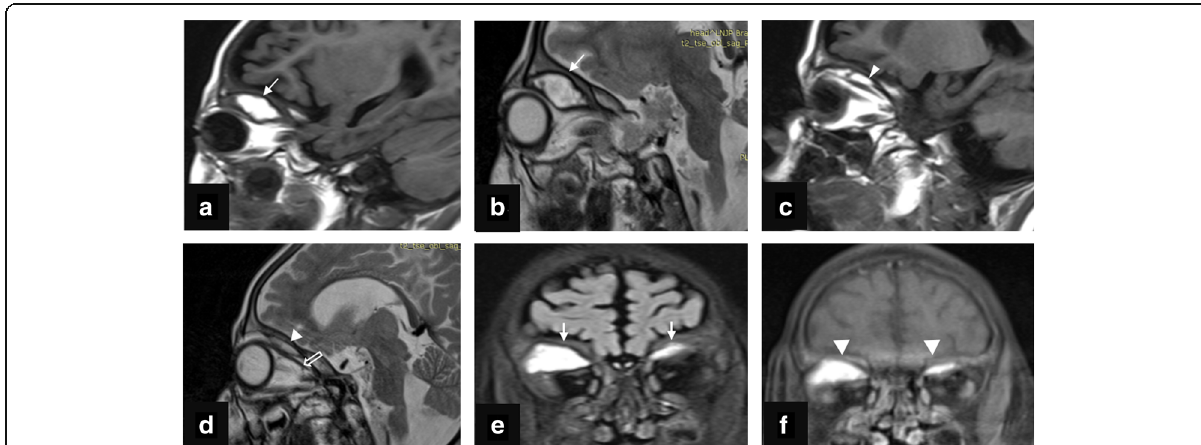
Fig. 3 a , b T1 and T2w sagittal images of right orbit reveal sharply marginated T1 and T2W hyperintense collection (arrows) along orbital roof with resultant downward displacement of superior rectus muscle. c , d T1- and T2-weighted sagittal images of the left eye reveal a similar smaller collection appearing hyperintense on T1 and T2W images (white arrowheads) along orbital roof with resultant downward displacement of superior rectus muscle (open arrow). e , f FLAIR coronal and T1 fat-suppressed images reveal the collections along bilateral orbital roof appearing hyperintense on FLAIR (arrows) with no signal suppression on fat-suppressed images (arrowheads)